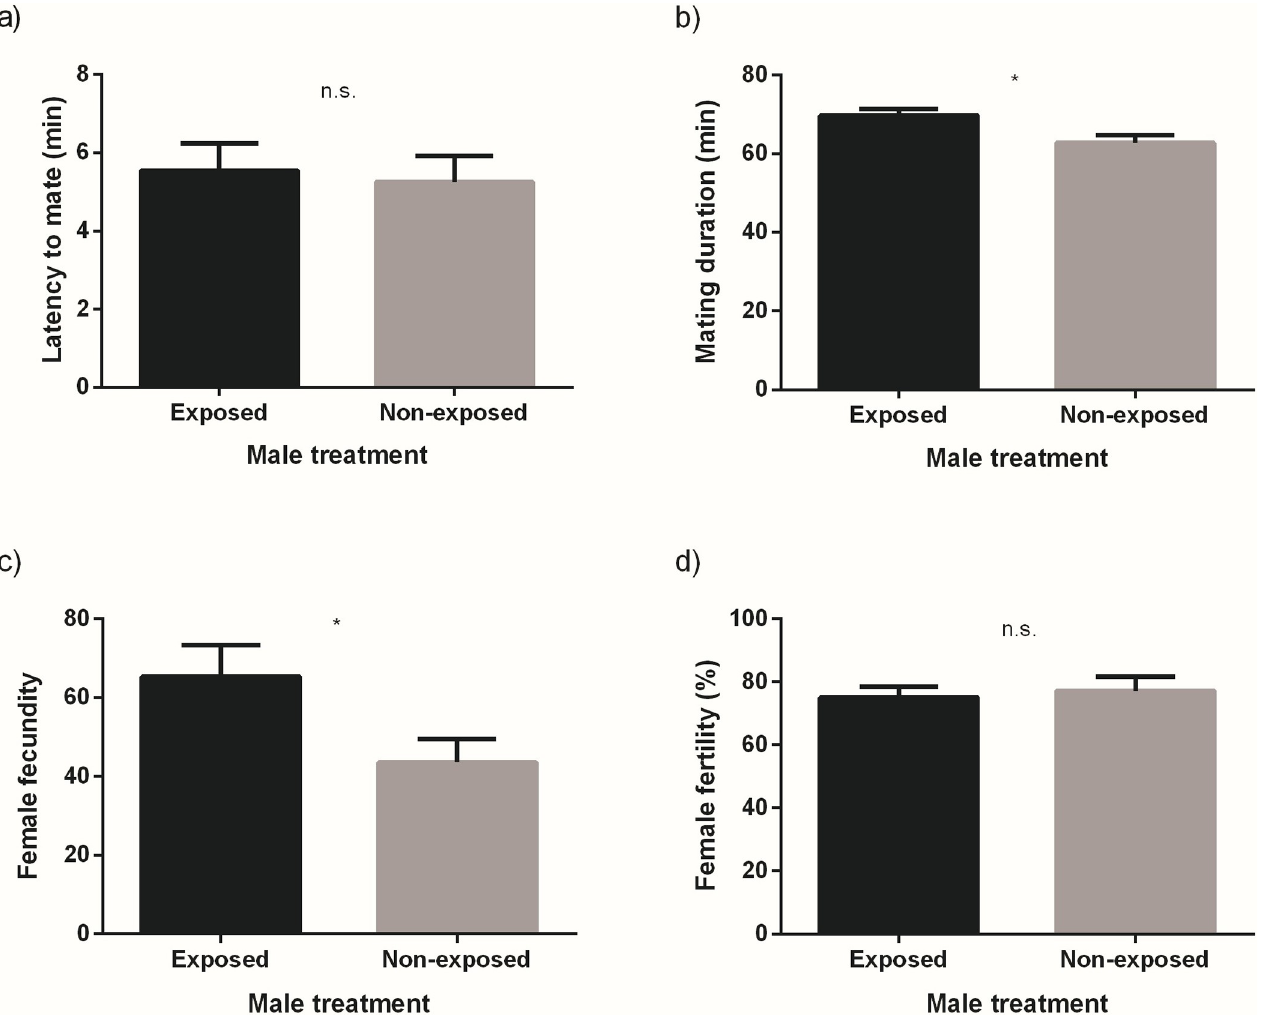
Fig 2. Latency to mate (A), mating duration (B), fecundity ( per capita ) (C) and fertility (D) for females mated to males exposed or non-exposed to guava volatiles. Bars represent mean values and SE for each variable. Results from the independent t-tests are indicated as follows: � statistically significant differences ( α = 0.05); n.s. non statistically significant